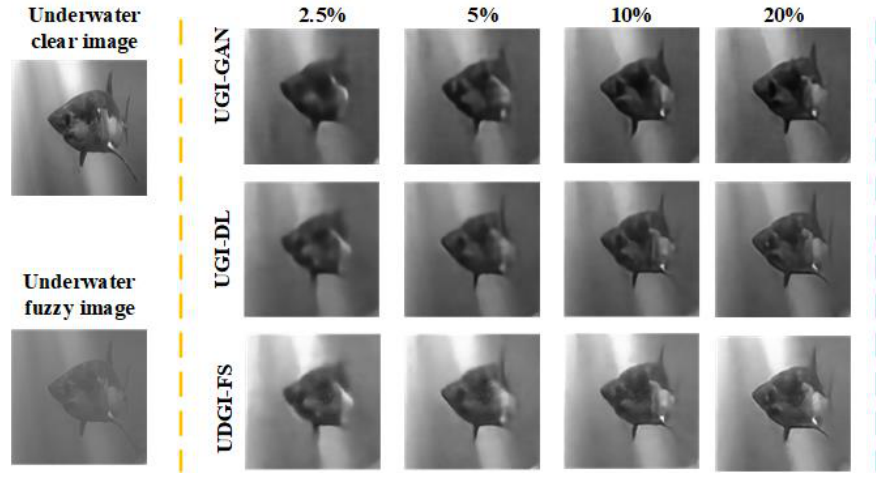
Figure 10. Comparison of reconstructed fish images of UDGI-FS, UGI-DL, and UGI-GAN at different sampling rates.